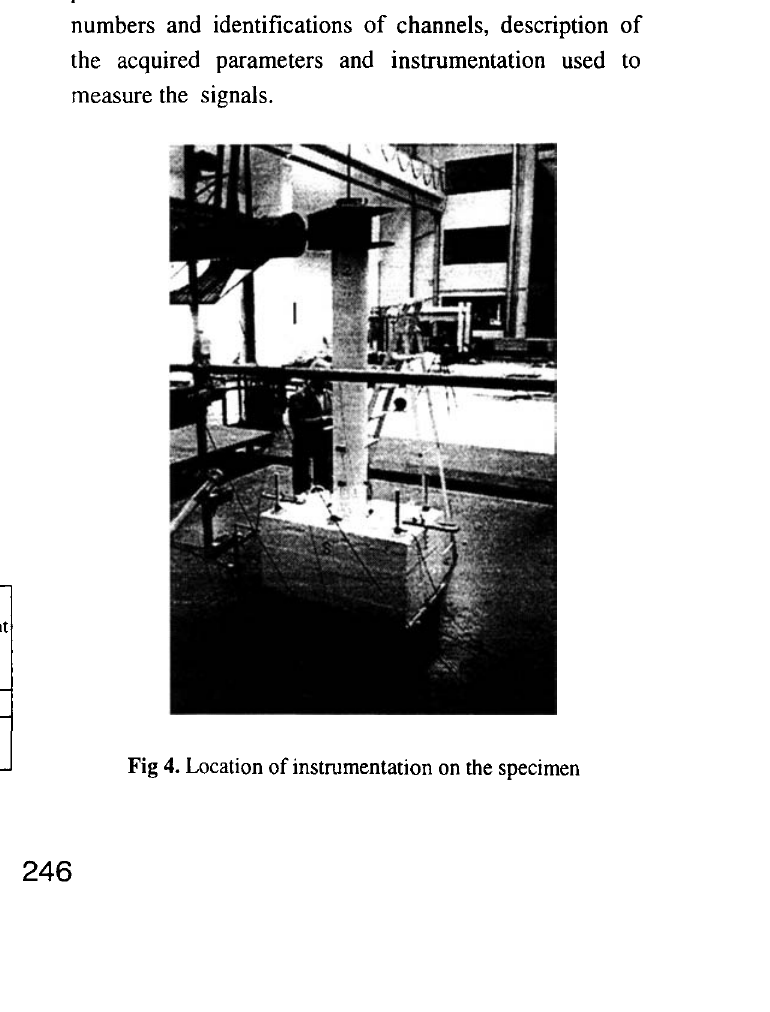
Fig 3. Geometry of the specimen